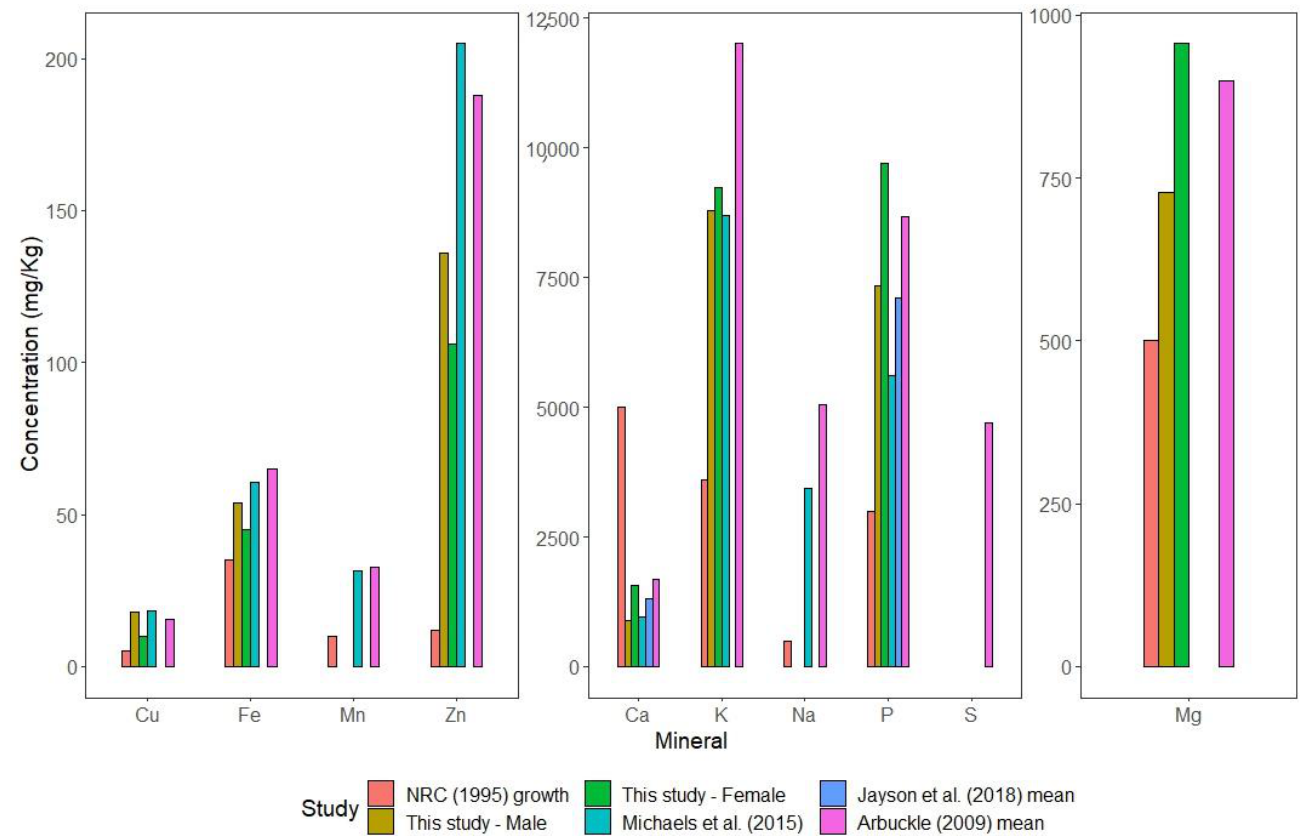
Figure 2. Mean mineral concentrations (mg/kg Dry Mass) of Gryllus bimaculatus crickets from this study and three others, compared with the recommended minimum concentration required for the growth of rodents [25]; no data are available for Sulphur. Data from Jayson et al. [23] represent crickets without supplementary dusting averaged across the two institutions reported. Data from Arbuckle [2] represent the mean of four gut-loaded treatments reported. Data from Michaels et al. [12] represent starved adult crickets; data for minerals other than Ca and P are the previously unpublished results of this study.